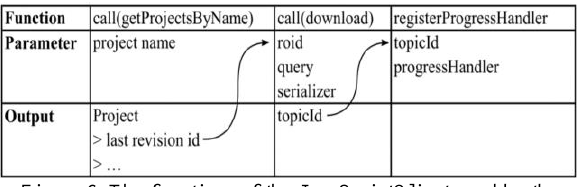
Figure 6: The functions of the JavaScriptClient used by the BimserverGltfRequestor to initiate a download and register a progress handler. The arrows indicate which output is used as an input for the subsequent function.